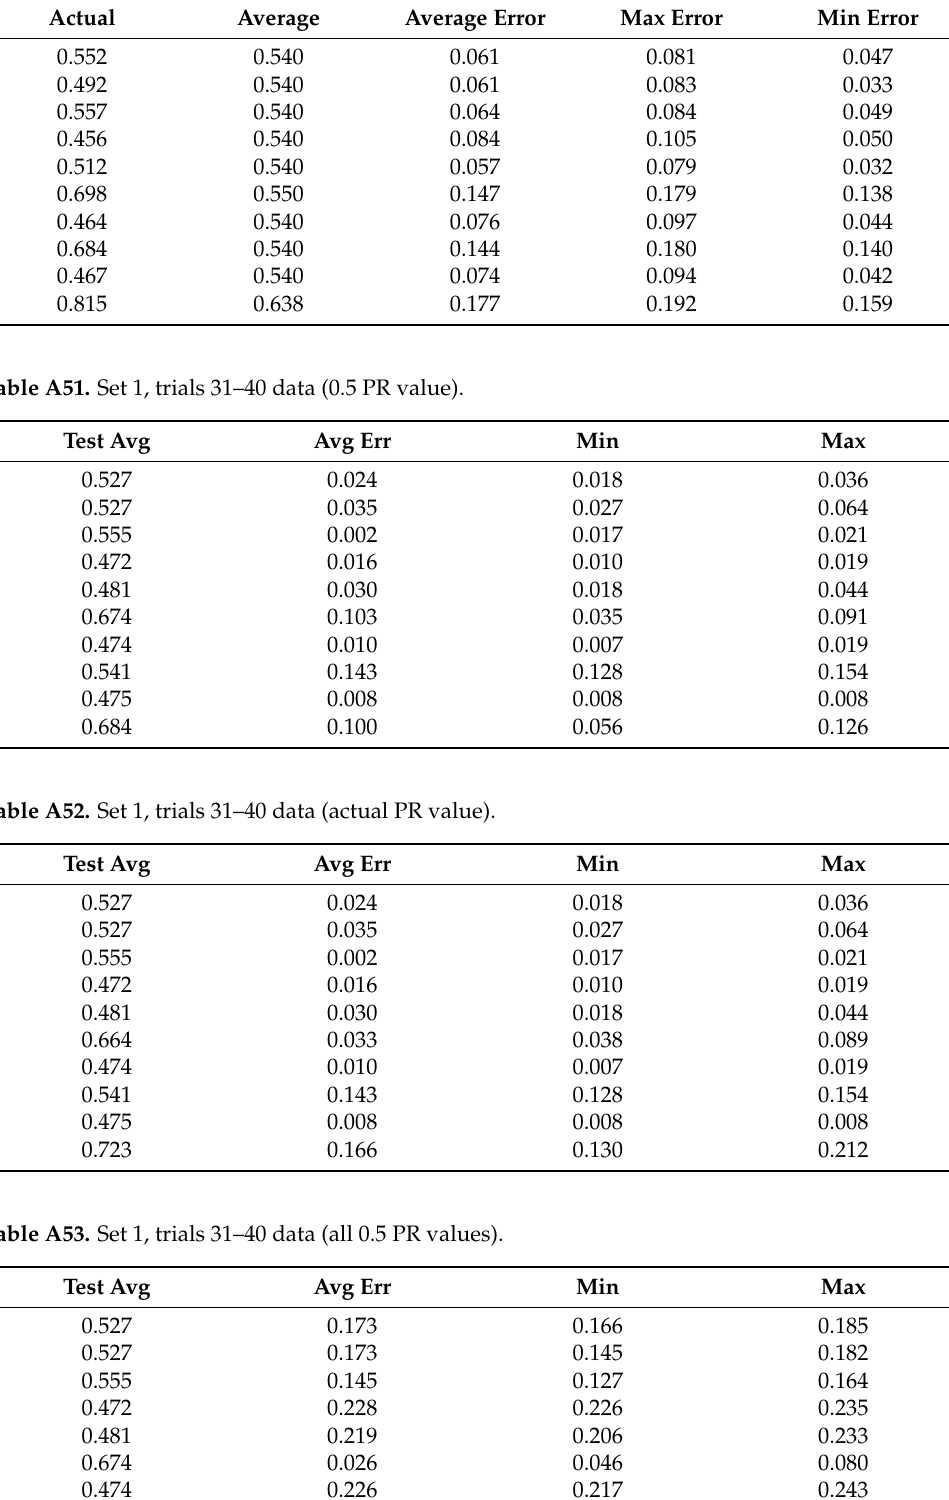
Table A50. Set 1, trials 31–40 data (average actual PR values).